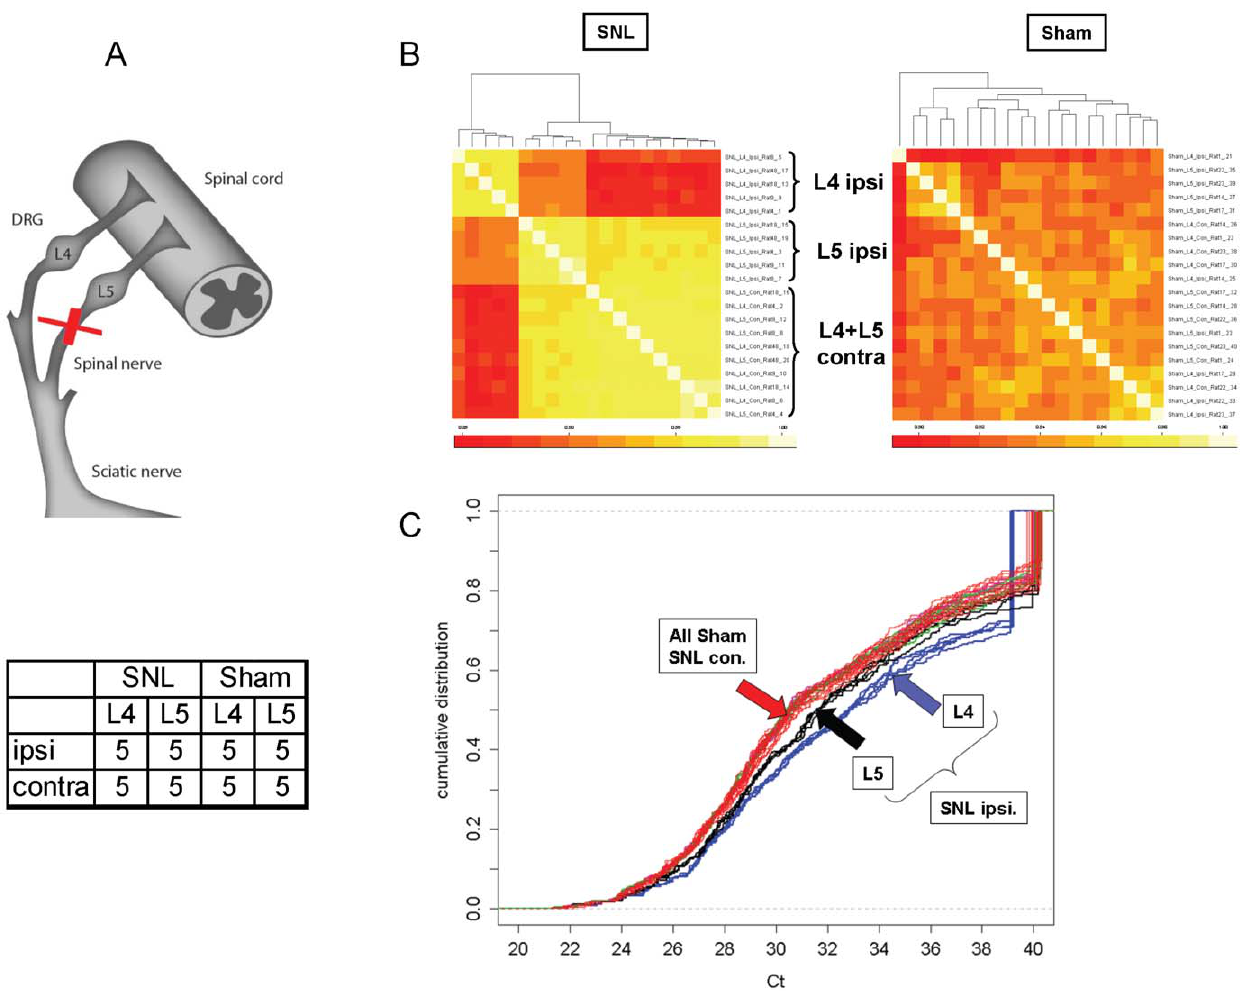
Figure 1. Profiling of miRNAs in DRG. a. Schematic representation of spinal L5 nerve ligation adapted from Decosterd and Woolf (Pain, 2000). Individual L4 and L5 DRG tissue samples were collected from the ipsi- and contralateral sides of 5 sham (no ligature) surgery and 5 SNL surgery rats four weeks after SNL for analysis. b. Pair-wise correlation of raw C T values among DRG samples. Heat map of sample-to-sample (Pearson) correlation of raw C T values from 248 detectable miRNAs in 40 DRG samples from the 8 experimental groups. Column and row labels are symmetric. c. Distribution of normalized C T values ( D C T ) in 40 samples. Each line represents C T distributions from one particular sample. The color represents the experimental group. L4 and L5 ipsilateral DRGs in the SNL cohort (blue and black, respectively) are clearly separated from each other and from the rest of the groups which appear to form an aggregate ‘group’ that contains all sham samples and all SNL contralateral samples. The majority of data points ( C T ranging from 29 to 39) in the blue curves are ‘‘shifted’’ to the right of the rest of the DRG sample distributions, indicating a general down-regulation (hence higher C T ) of miRNA expression in L4 ipsilateral DRGs of the SNL cohort. doi:10.1371/journal.pone.0017670.g001 Figure 4). An overlapping set of 153 transcripts emerges when the